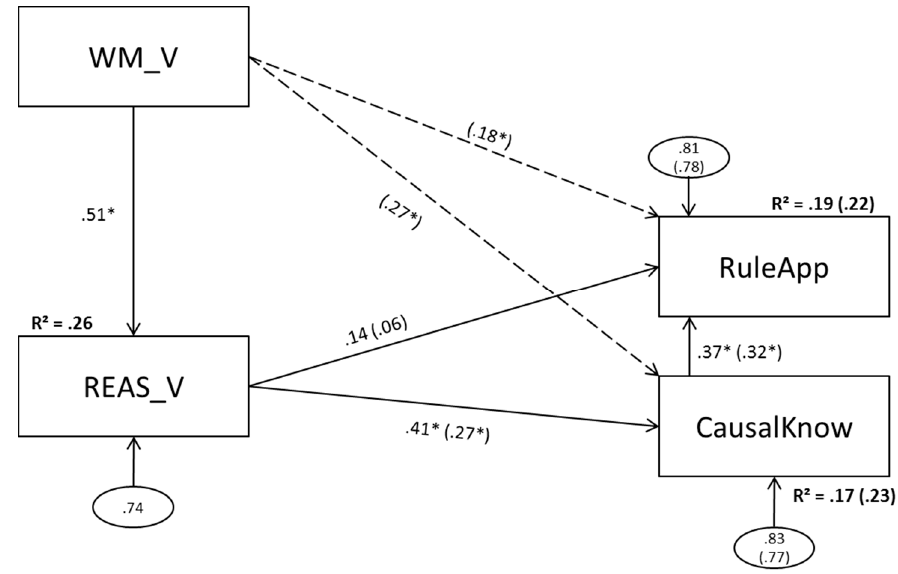
Figure 5. Model 4a(b): Verbal working memory components as predictors of figural reasoning; verbal reasoning (and verbal working memory) as predictors of problem solving. WM_V = verbal working memory; REAS_V =verbal reasoning; CausalKnow = causal knowledge; RuleApp = rule application. Dashed lines and values in parentheses depict changes in model 4b. Statistically significant paths are marked with an asterisk ( α = .05).